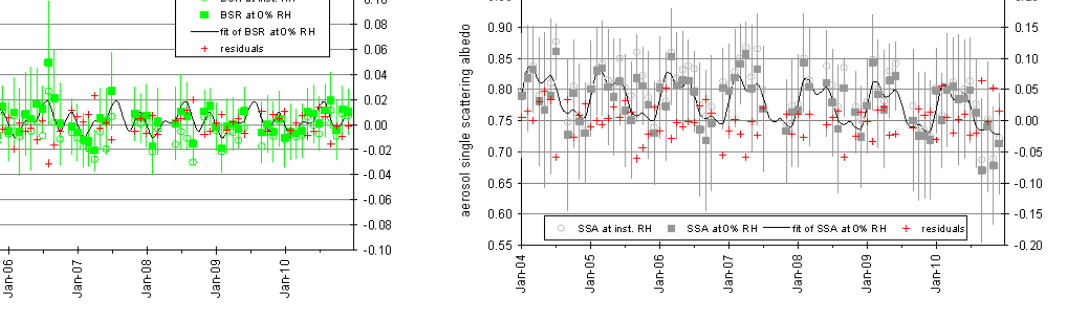
Figure 5. Variations in the aerosol backscatter ratio at 550nm at IPR: monthly mean values at instrumental RH (open circles), at 0% RH (squares), least mean square fit of the monthly mean values at 0% RH (line), and residuals (crosses, right axis). Error bars show the standard deviation of the monthly mean values at 0% RH.